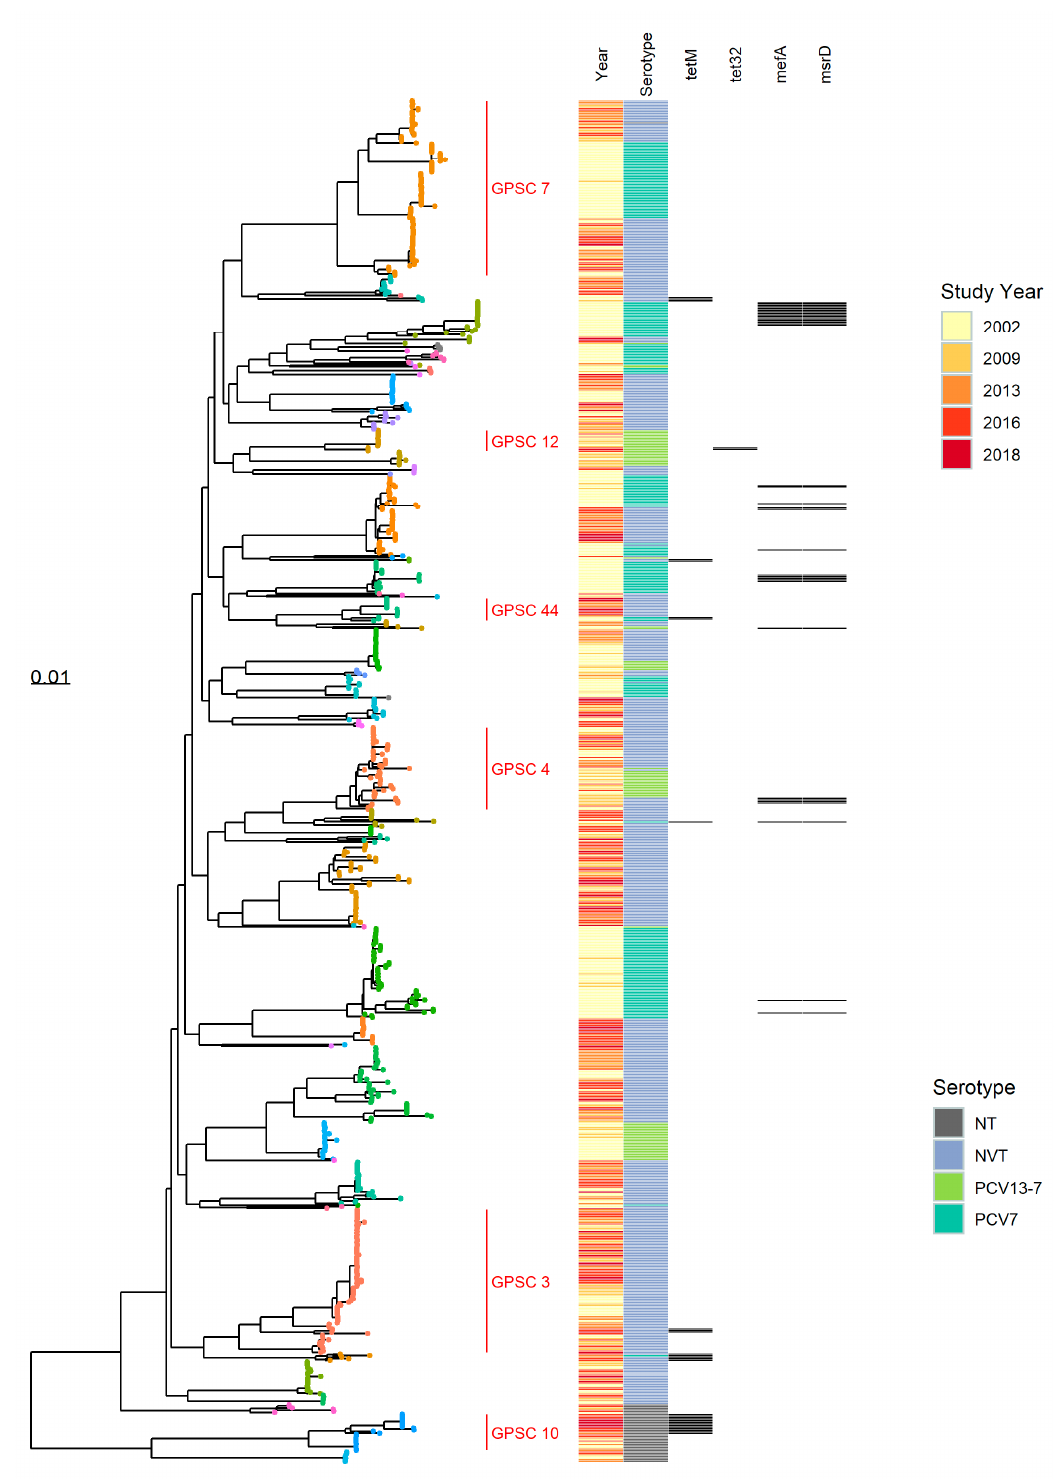
Figure 3. RAxML tree (midpoint rooted) calculated from the Roary core-genome alignment of all carriage study genomes with a heatmap showing study year, serotype category and antibiotic resistance (AMR) markers. Tree tip points are colored by GPSC cluster (key not shown, GPSCs 3, 4, 7, 10, 12 and 44 are labelled). Scale is number of substitutions per site.